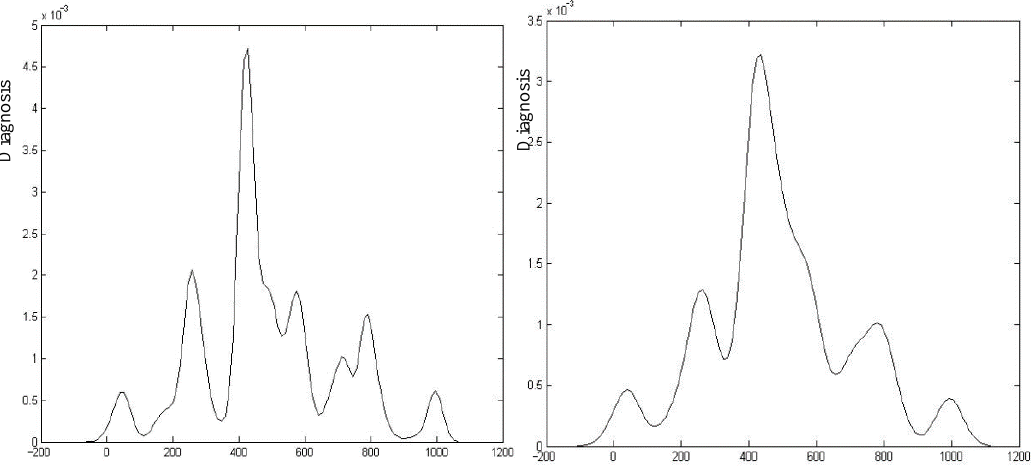
Figure 3. Transformed diabetic data based on probability ( ksdensity ) [9] .